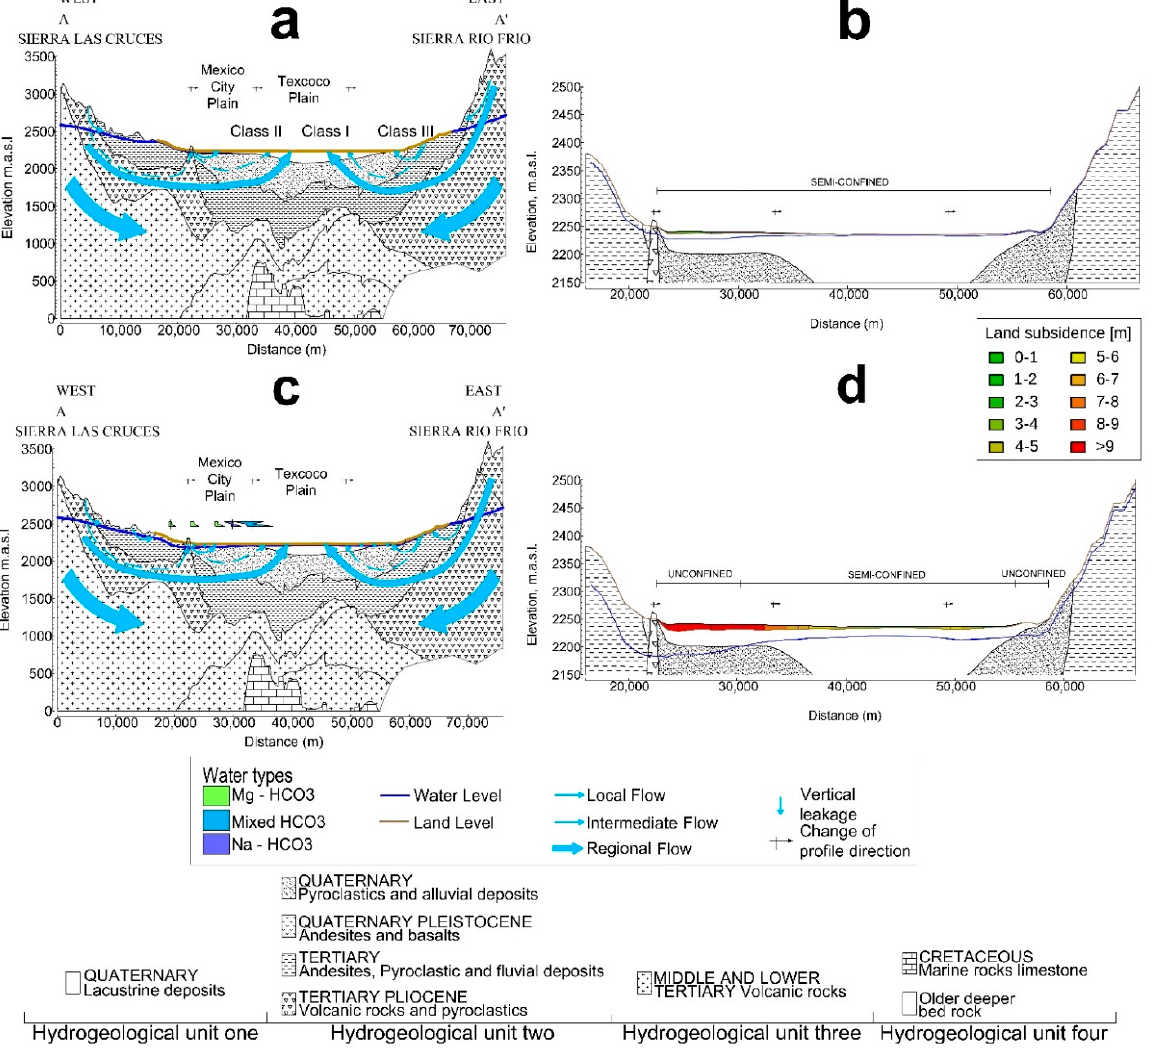
Figure 9. Hydrogeological cross section; location is shown in Figure 4 as CC’-AA’. ( a ) General groundwater flow direction and groundwater level; geochemical water Chase Palmer classification, 1950. ( b ) Land subsidence in the zoomed area (between 20,000 and 60,000 m of distance), water level and land level, 1950. ( c ) General groundwater flow direction and groundwater level; geochemical water types, 1990. ( d ) Land subsidence in the zoomed area (between 20,000 and 60,000 m of distance), water level and land level,